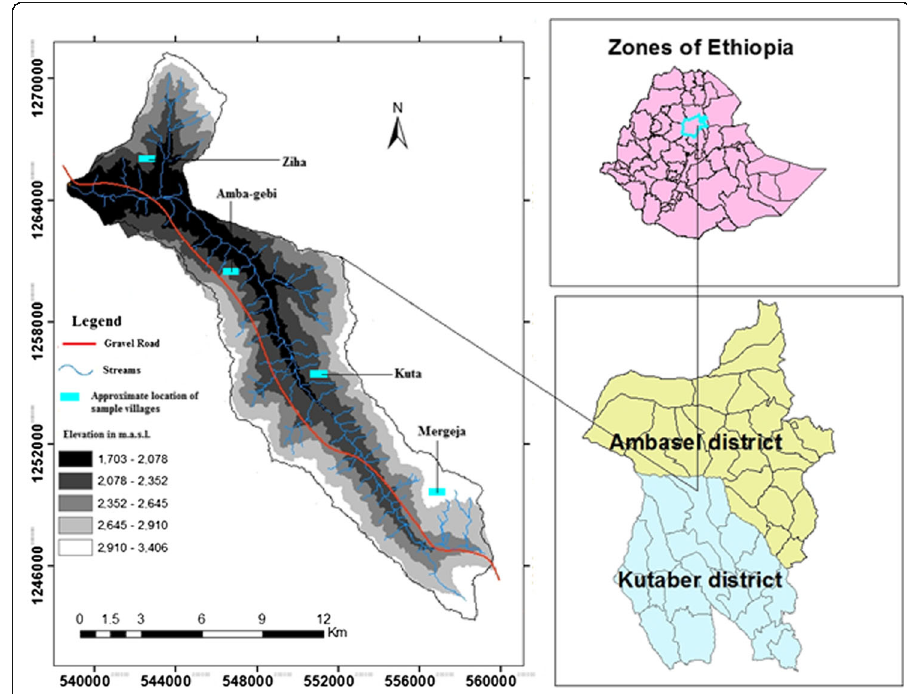
Fig. 1 Location map of the study